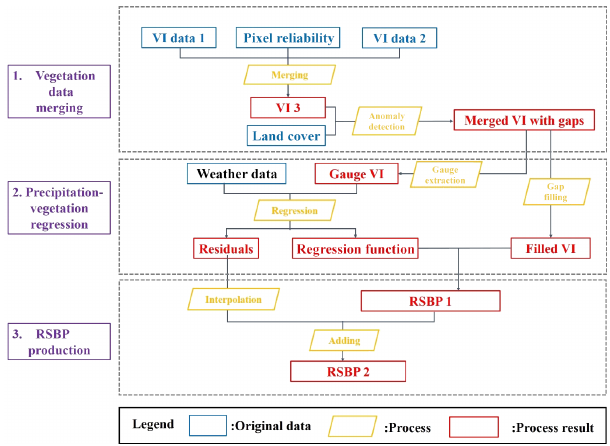
Figure 1. Flow chart of the satellite–gauge–vegetation fusion framework